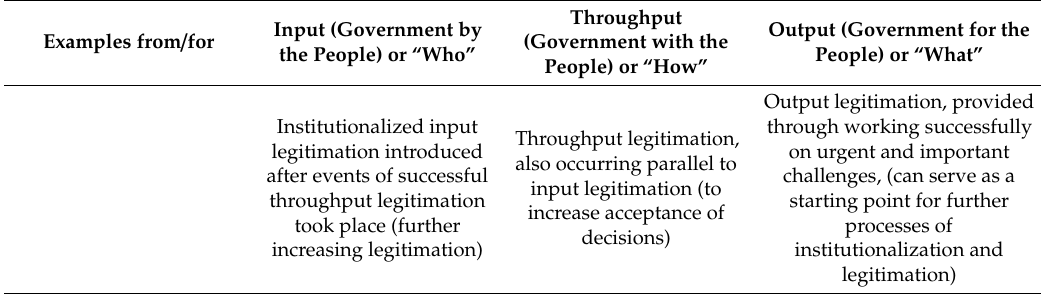
Table 2. Development of input, throughput, and output legitimation in metropolitan